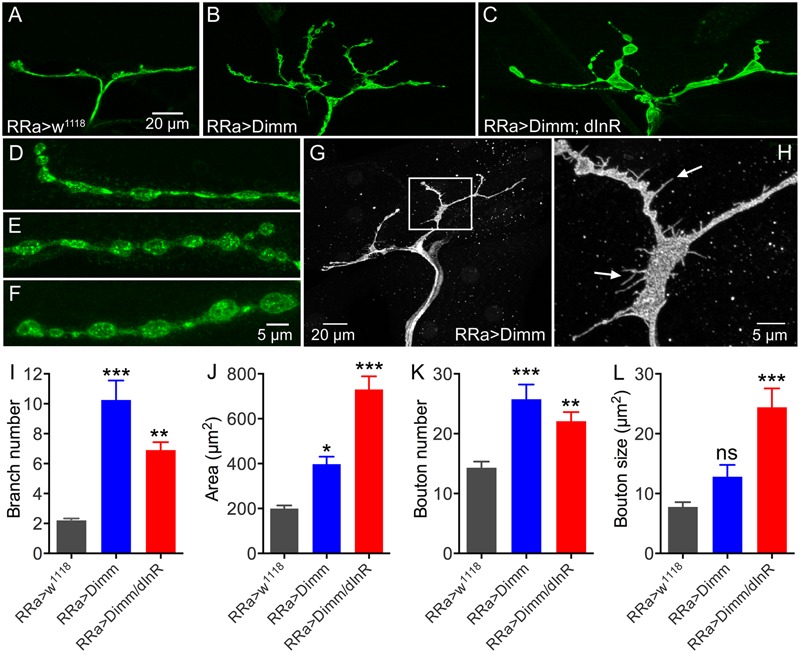
The axon terminations of the aCC neurons enlarge after ectopic expression of Dimm and Dimm/dInR. (A–C) Axon terminations of aCC neurons on muscle 1 enlarge and display more branches after Dimm expression. This is accentuated by coexpression of the dInR (C). (D–F) Details of boutons of axon terminations (D, RRa > w1118; E, RRa > Dimm; F, RRa > Dimm; dInR). (G,H) After ectopic expression of Dimm the axon terminations commonly display filopodia-like protrusions, detail of inset in (G) is shown in (H) at higher magnification (arrows indicate filopodia-like protrusions). (I–L) Quantification of branch number (I), branching area (J), bouton number (K) and bouton size of aCC axon terminations in control, Dimm and Dimm+dInR expressing neurons. Data are presented as means ± SEM; with 8–11 larvae from three biological replicates (∗p < 0.05, ∗∗p < 0.01, ∗∗∗p < 0.001, ns, not significant, as assessed by one way ANOVA followed by Tukey’s multiple comparisons test).